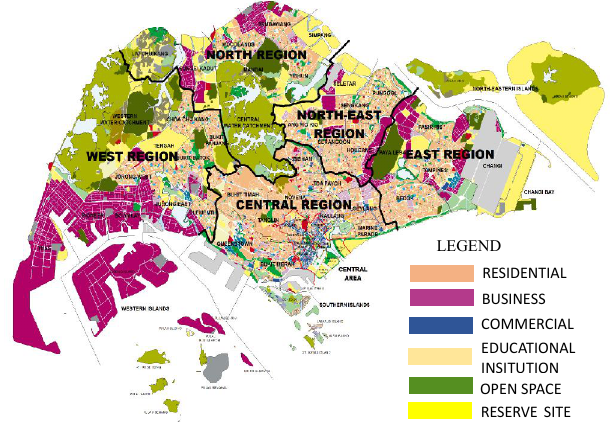
Figure 7. Master Plan 2008 by Urban Redevelopment Authority (URA)